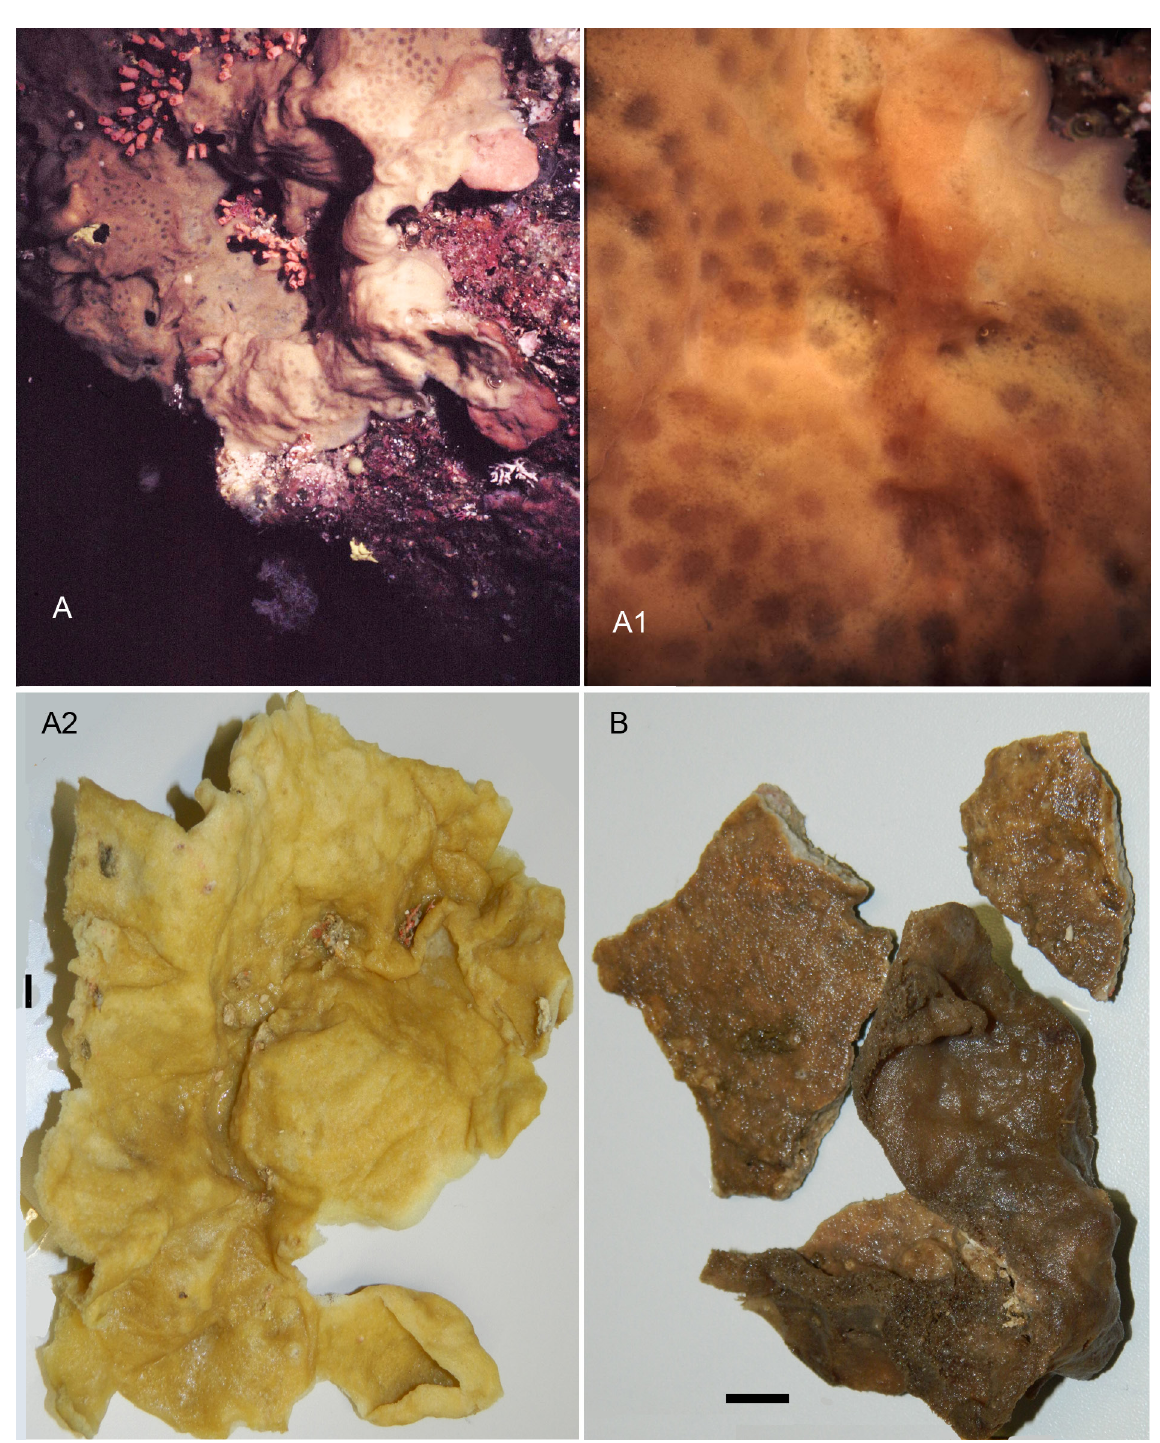
Fig. 4. Haliclona ( Flagellia ) indonesiae subgen. et sp. nov. A . Holotype (RMNH Por. 2326) in situ at Manado, North Sulawesi, Indonesia. A . Detail of surface of in situ holotype. A 1 specimen (scale bar = 1 cm). B . Fragmented paratype (ZMA Por. 08160) from Ambon, Indonesia (scale bar = 1